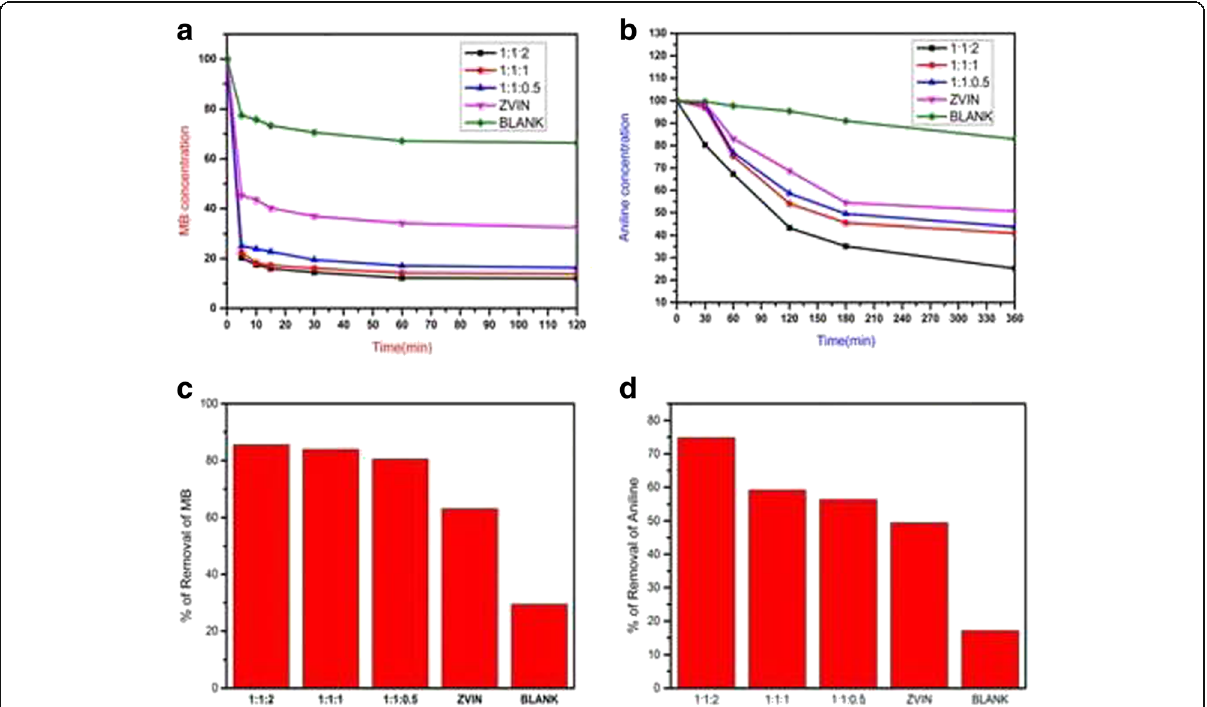
Fig. 5 Effect of contact time on percentages of concentrations ( a ) MB and ( b ) aniline and removal of percentage of ( c ) MB and ( d ) aniline as a function of composition of